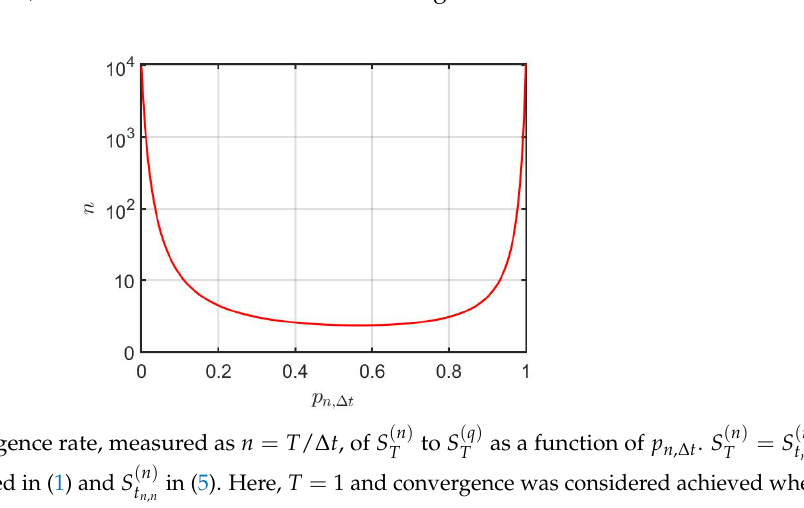
( n ) in (5). Here, T = 1 and convergence was considered achieved when t n , n